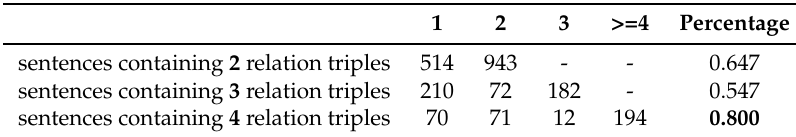
Table 4. Statistics Results.